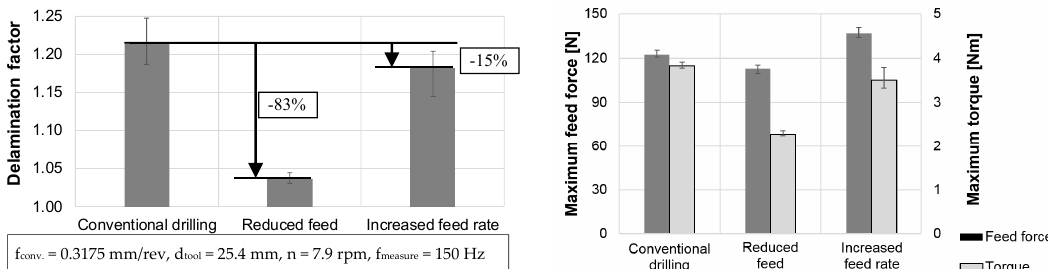
Figure 5. Delamination factor (bore entrance) ( left ) and maximum tool loads applying the different feed strategies ( right ).